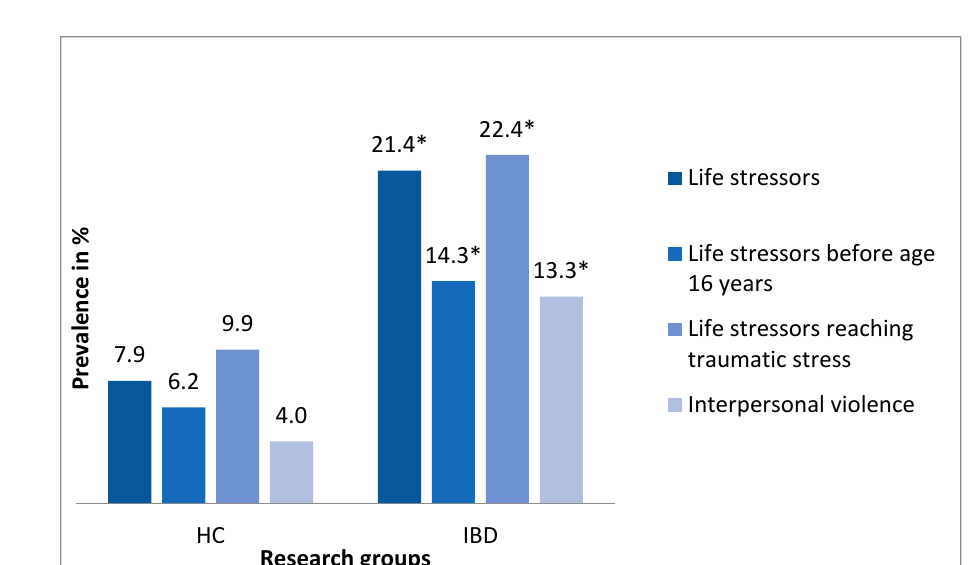
Figure 1. Prevalence of life stressors in the research groups: HC = healthy control group ( N = 405), IBD = inflammatory bowel disease patients ( N = 98). The differences in the occurrence of life stressors between the groups were assessed by a test of proportions (Z-test); * p < 0.05. Life stressors scores dichotomised according to mean + SD value.